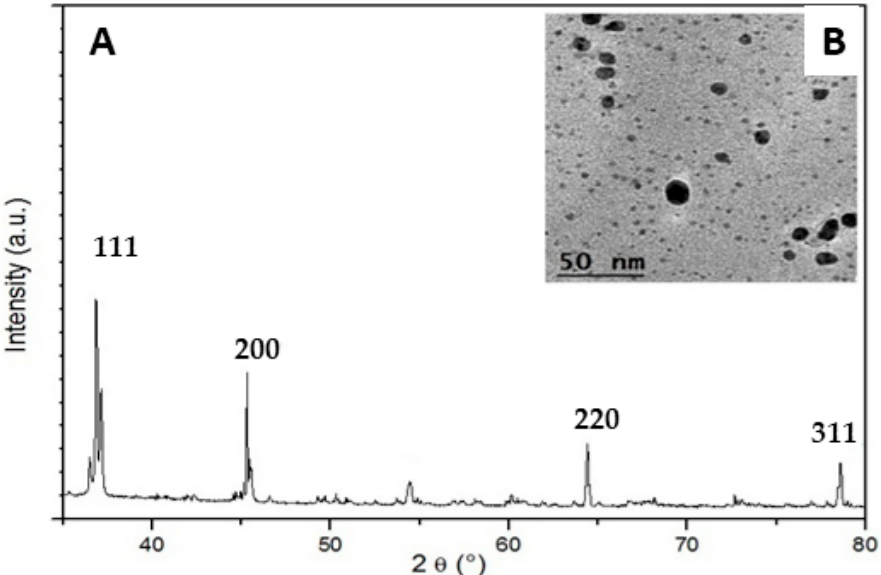
Figure 3. ( A ) XRD pattern and ( B ) TEM image of silver nanoparticles biosynthesized from Aeonium Figure 3. (A) XRD pattern and (B) TEM image of silver nanoparticles biosynthesized from Aeonium haworthii leaf extract. haworthii leaf extract.